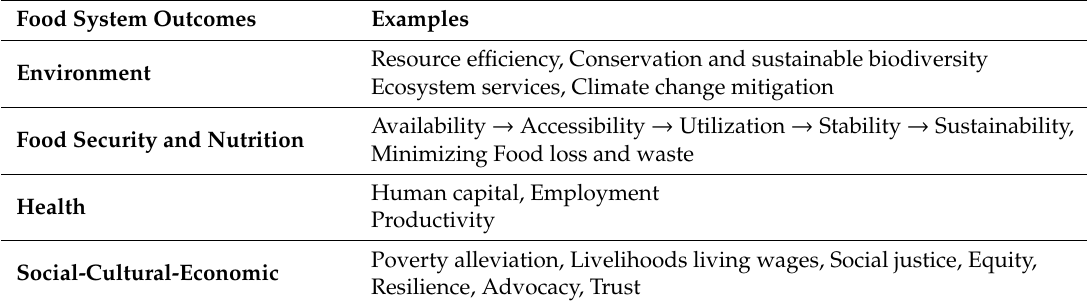
Table 2. Four Food System